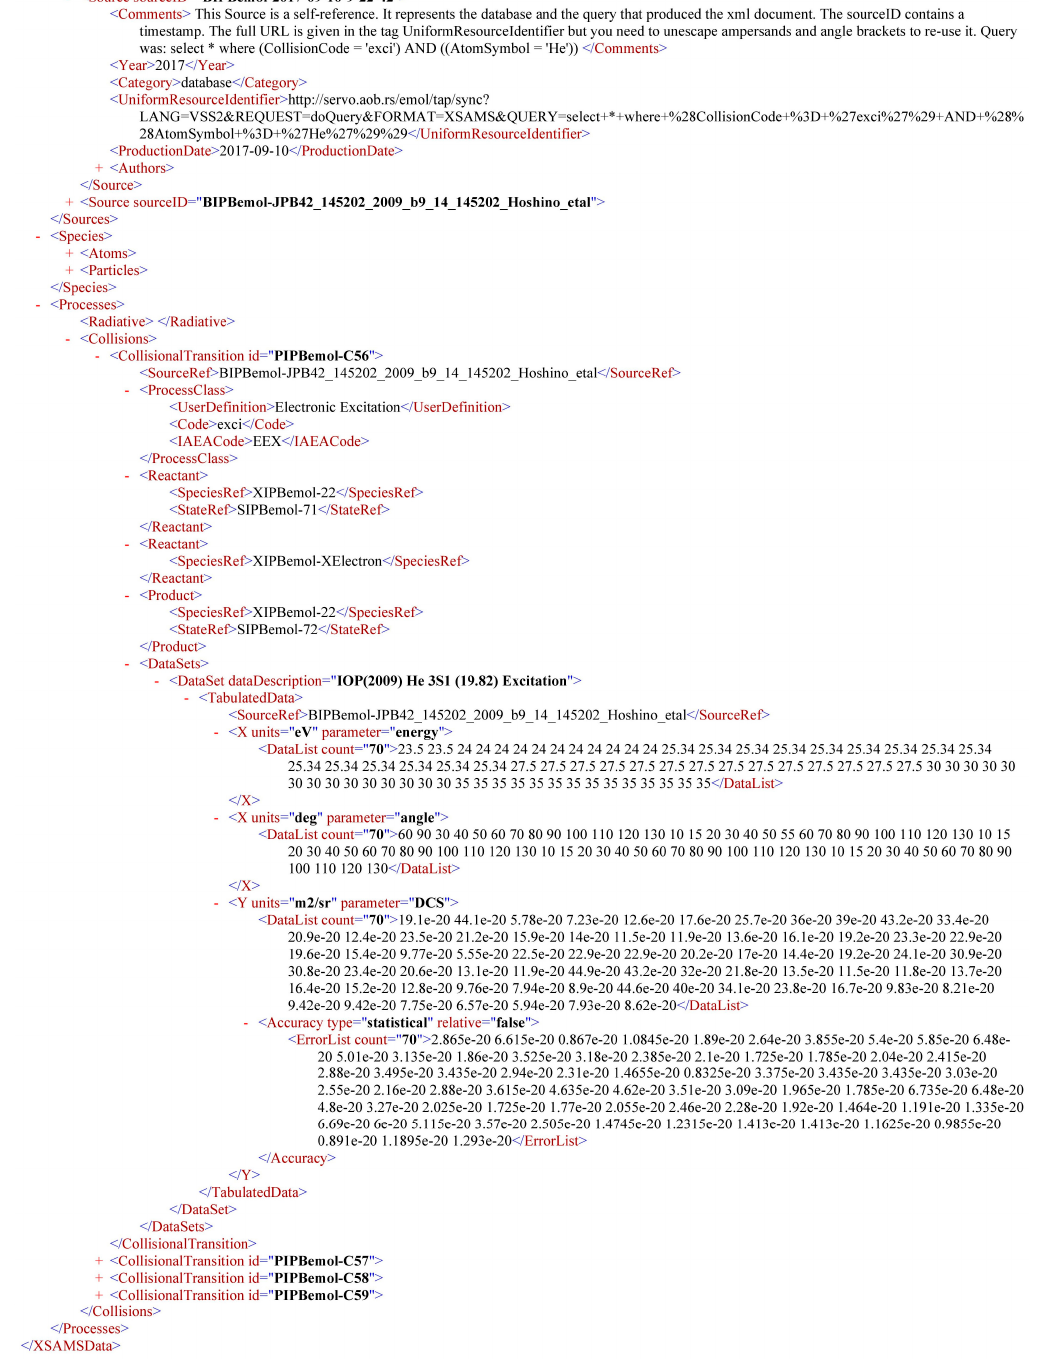
Figure 2. XSAMS output table for differential cross section data for He electron excitation.